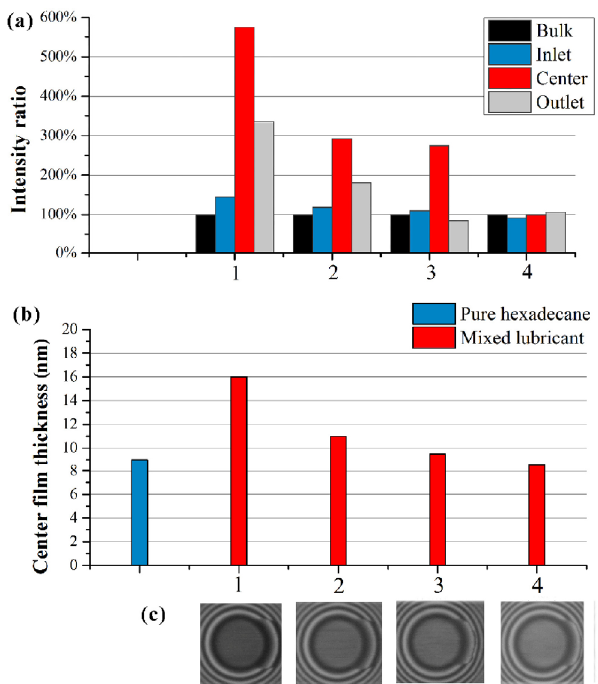
Fig. 7 Schematic of the binary multilayer model in TFL in the contact region: (a) polar additive in nonpolar base oil; (b) polar additive in polar base oil; and (c) nonpolar additive in nonpolar base